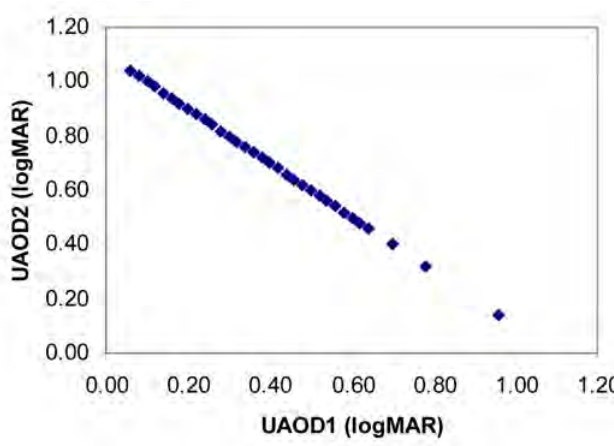
Figure 1. The scatter plots for UAOD1 plotted against UAOD2. The plot shows a perfect inverse relationship between methods 1 and 2. All the 140 data points are not shown due to the fact that most of the coordinates are the same and the points therefore, lie on each other.